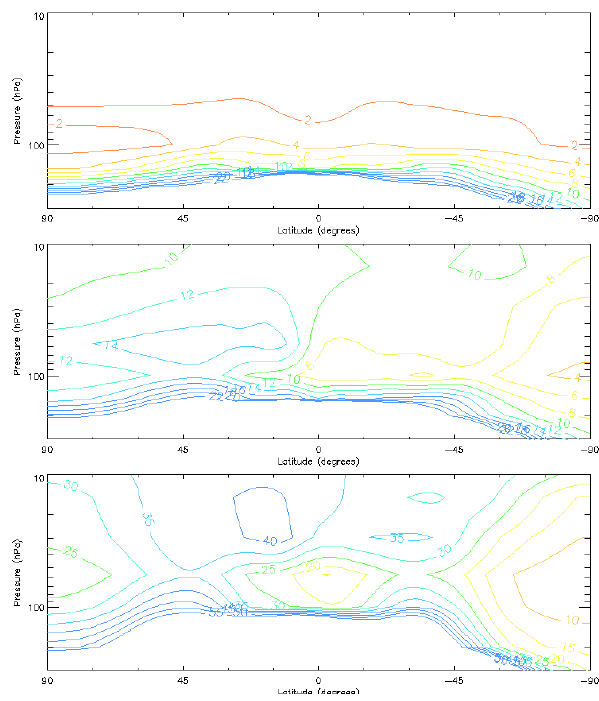
Fig. 1. Time averaged zonal-mean cross sections of specific humid- ity in ppmv in the standard-parameter version of HadSM3 with pre- industrial CO 2 levels-STD1 (top), the low-entrainment perturbed version of HadSM3 with pre-industrial CO 2 -LEP1 (middle) and the low-entrainment perturbed version under a doubling of CO 2 -LEP2 (bottom). Note the different contour intervals in the two plots (2, 2, and 5ppmv